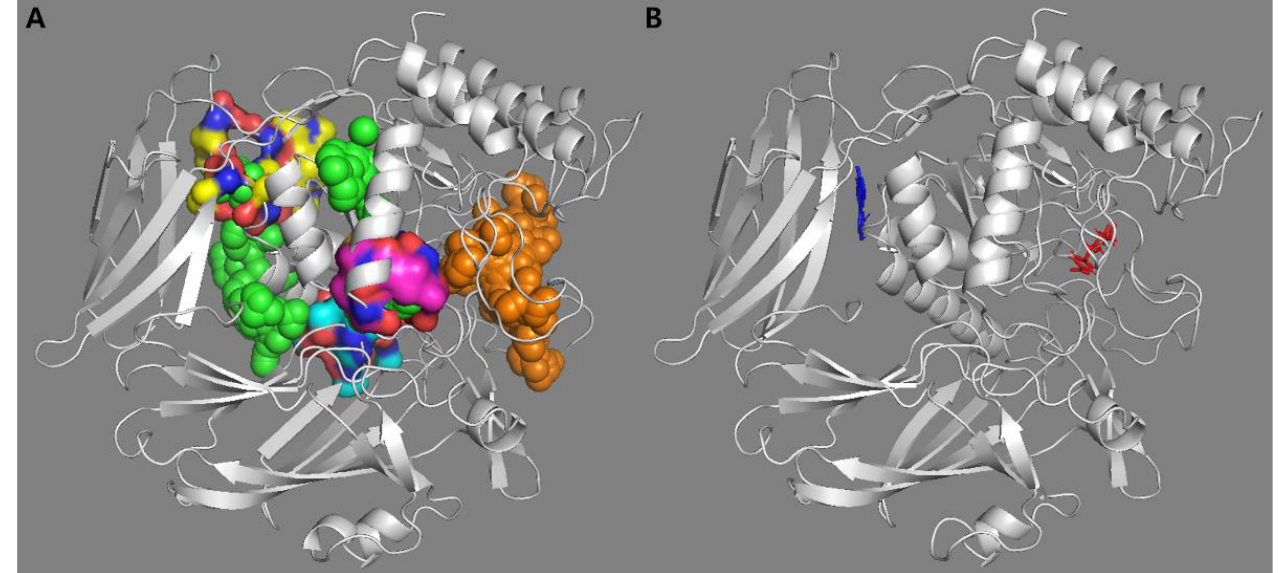
Figure 4. Predicted binding sites (( A ); orange spheres: active site, green spheres: possible allosteric binding site predicted by AllositePro, and rainbow spheres: possible allosteric binding site predicted by PASSer2.0) and docking pose results of the substrate and compound 1 with the β -glucuronidase enzyme (( B ); substrate: red; compound 1 : blue).